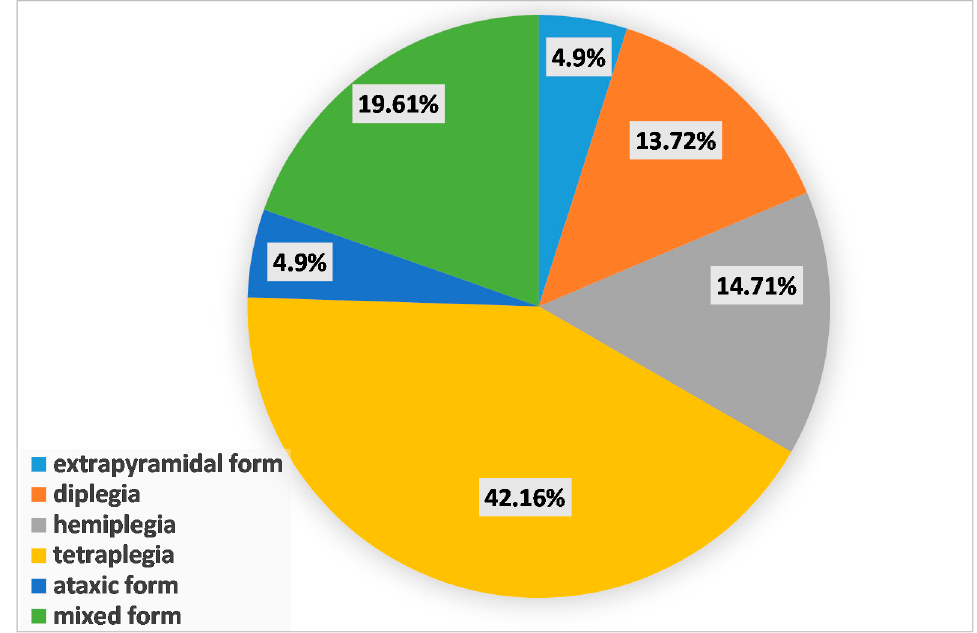
Figure 1. Distribution of types of cerebral palsy according to Ingram’s classification [20] in patients with epilepsy.